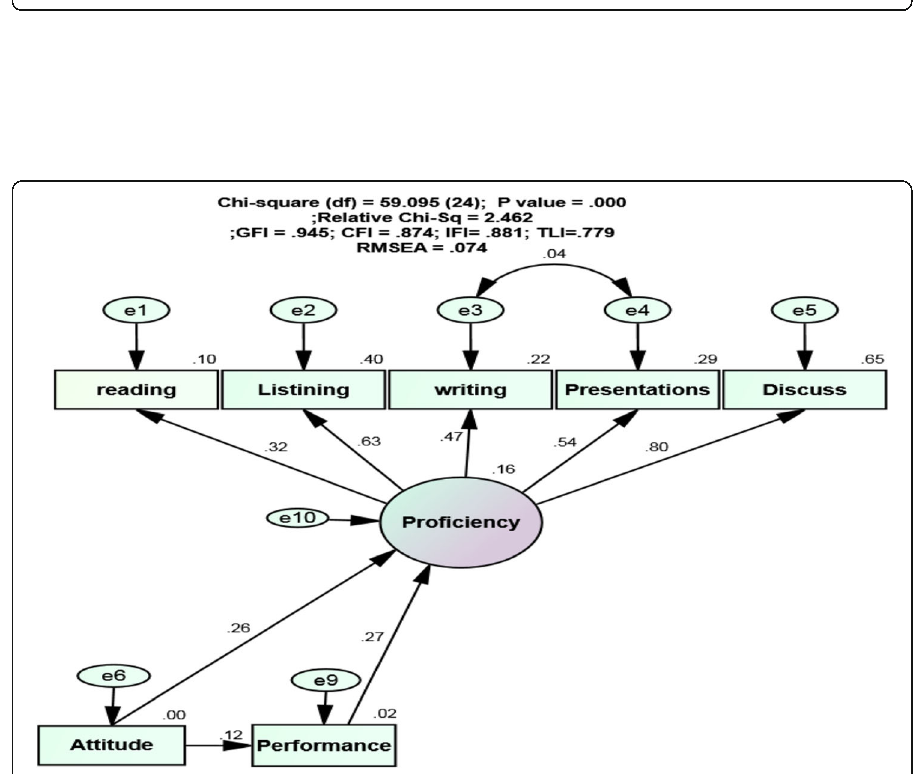
Fig. 5 Testing the effect of variables on performance for a group with low work experience based on standard